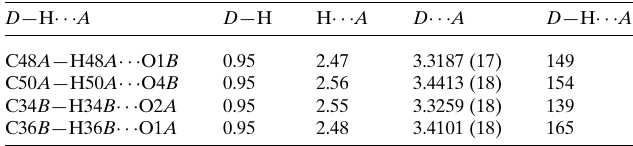
Table 1 Hydrogen-bond geometry (A˚ , (cid:2)